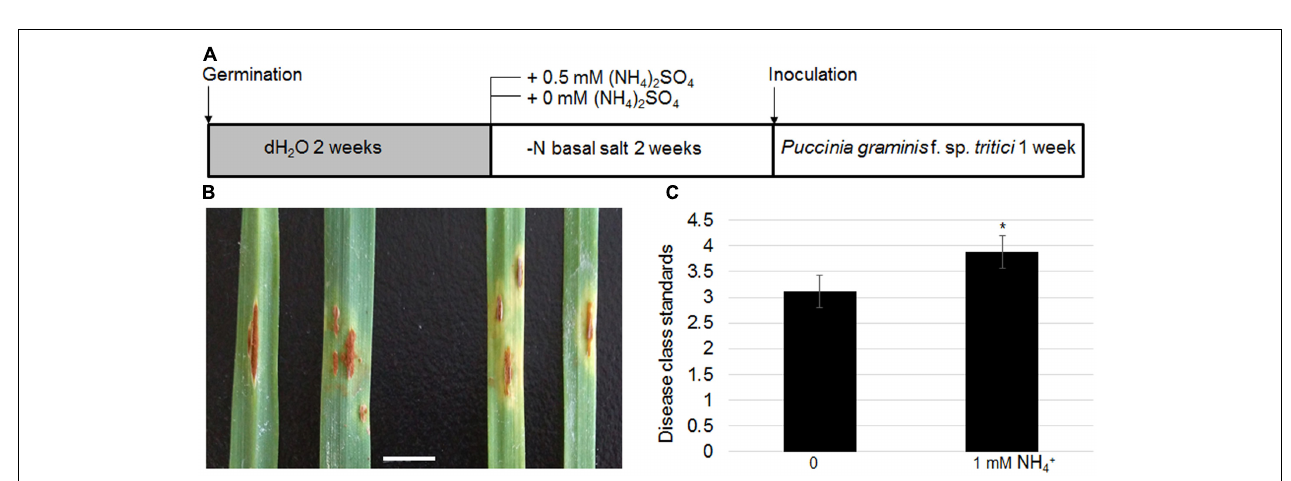
FIGURE 8 | Effects of N-deficient growth conditions on wheat stem rust disease. Schematic diagram showing plant growth conditions for testing N effects on stem rust disease. Four-week-old LC seedling was inoculated with Pgt (A) . Photograph of uredinia growth in the leaves of LC grown on NH + 4 -supplied (left panel) or N-free media (right panel). Bar = 1 cm (B) . Disease class standards were calculated following the international standard for wheat stem rust disease corresponding to the phenotypes shown in (B,C) . Significant differences were analyzed ( ∗ P < 0.05).